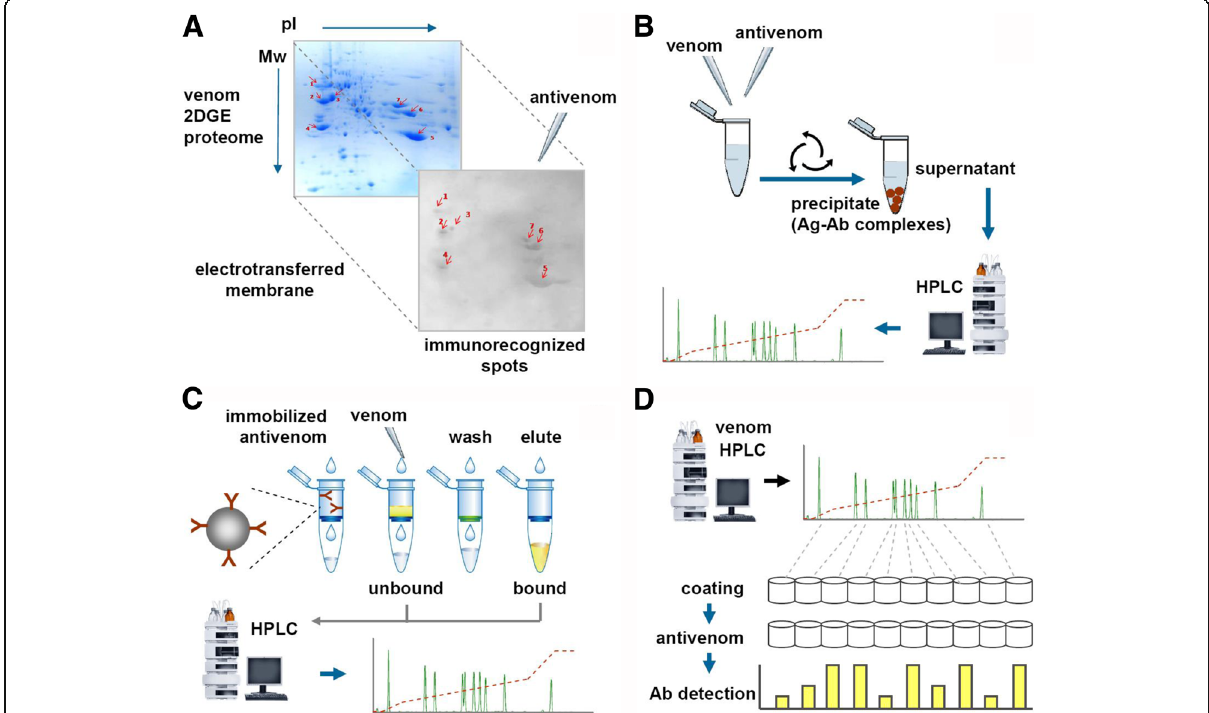
Fig. 3 Antivenomic analytical strategies. A schematic representation of immunological approaches that have been combined with proteomic analysis of snake venoms, aiming to assess the immunorecognition of venom components by antibodies present in a given antivenom. a Immunoblotting, performed on electrotransferred membranes from two-dimensional gel electrophoresis (2DE) venom separations, identifies spots that are immunorecognized by the antivenom, in an essentially qualitative way. Immunoblotting can also be performed on membranes from the electrophoresis step (second dimension separation by SDS-PAGE) of the snake venomics strategy (see text and Fig. 1c). b ‘ First generation ’ antivenomics evaluates the immunodepletion of venom components after addition of antivenom and removal of precipitated immunocomplexes. The remaining supernatant is analyzed by HPLC and its profile is compared to that of a control venom aliquot. Differences in the chromatographic peaks between the antivenom-treated venom and the control venom can be quantified by integration of their peak areas, representing the immunodepletion of recognized components. c ‘ Second generation ’ antivenomics evaluates the venom components that are captured by an antivenom that has been covalently linked to beads, following the principles of immunoaffinity chromatography. Whole venom is incubated with this matrix and the unbound components are collected. After washing out the non-binding venom components, a change in pH elutes the bound venom fraction. Both samples are finally analyzed by HPLC, and their profiles are compared to that of a control sample of venom. Quantitative estimations of the degree of immunorecognition of components are performed as described for panel b by integration of chromatographic peak areas [58]. d HPLC/ELISA-based assessment of immunorecognition of venom components by an antivenom, or HPLC/ELISA-based immunoprofiling, is performed by coating microwell plates with a normalized amount of venom fractions obtained from the HPLC profile of the venom. Then, antivenom is added to each well and the bound antibodies (Ab) are detected by conventional